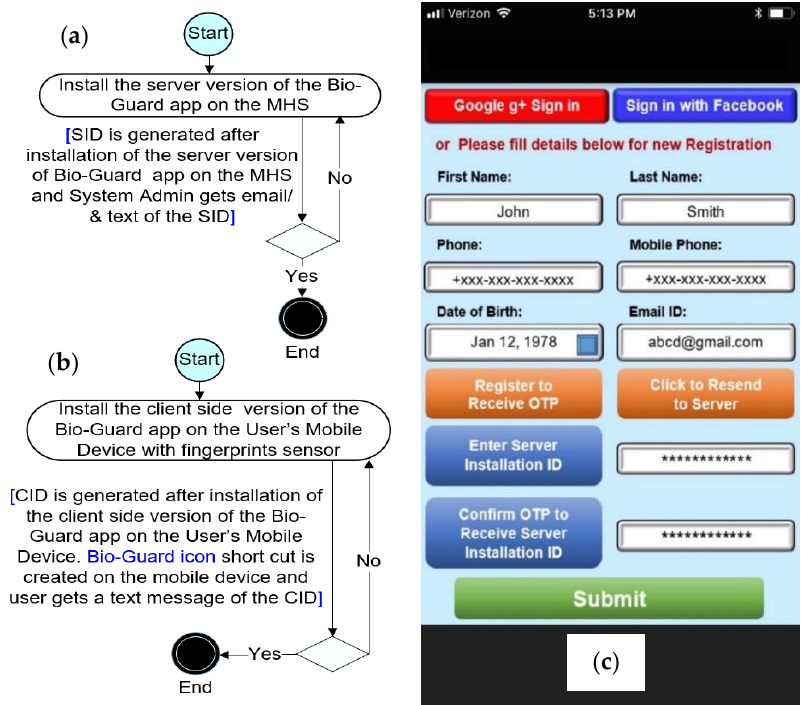
Figure 2. ( a , b ) demonstrate the generation of SID and client installation ID (CID) on the server and client-side of the Bio-Guard app, respectively, after the installation. ( c ) The Bio-Guard app after it expanded on a Samsung android mobile phone screen, after a single tap of the Bio-Guard icon.